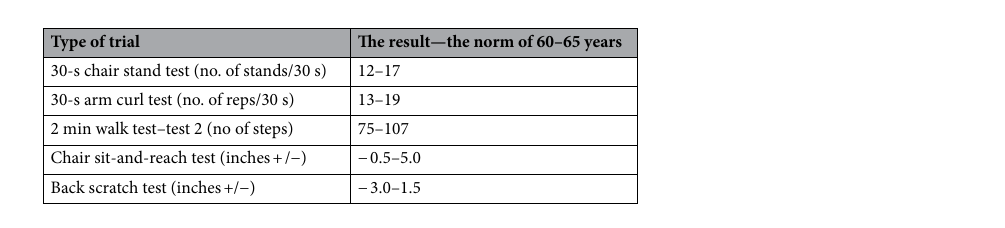
Table 3. Standards for SFT tests used in the study (Jones C.J, Rikli